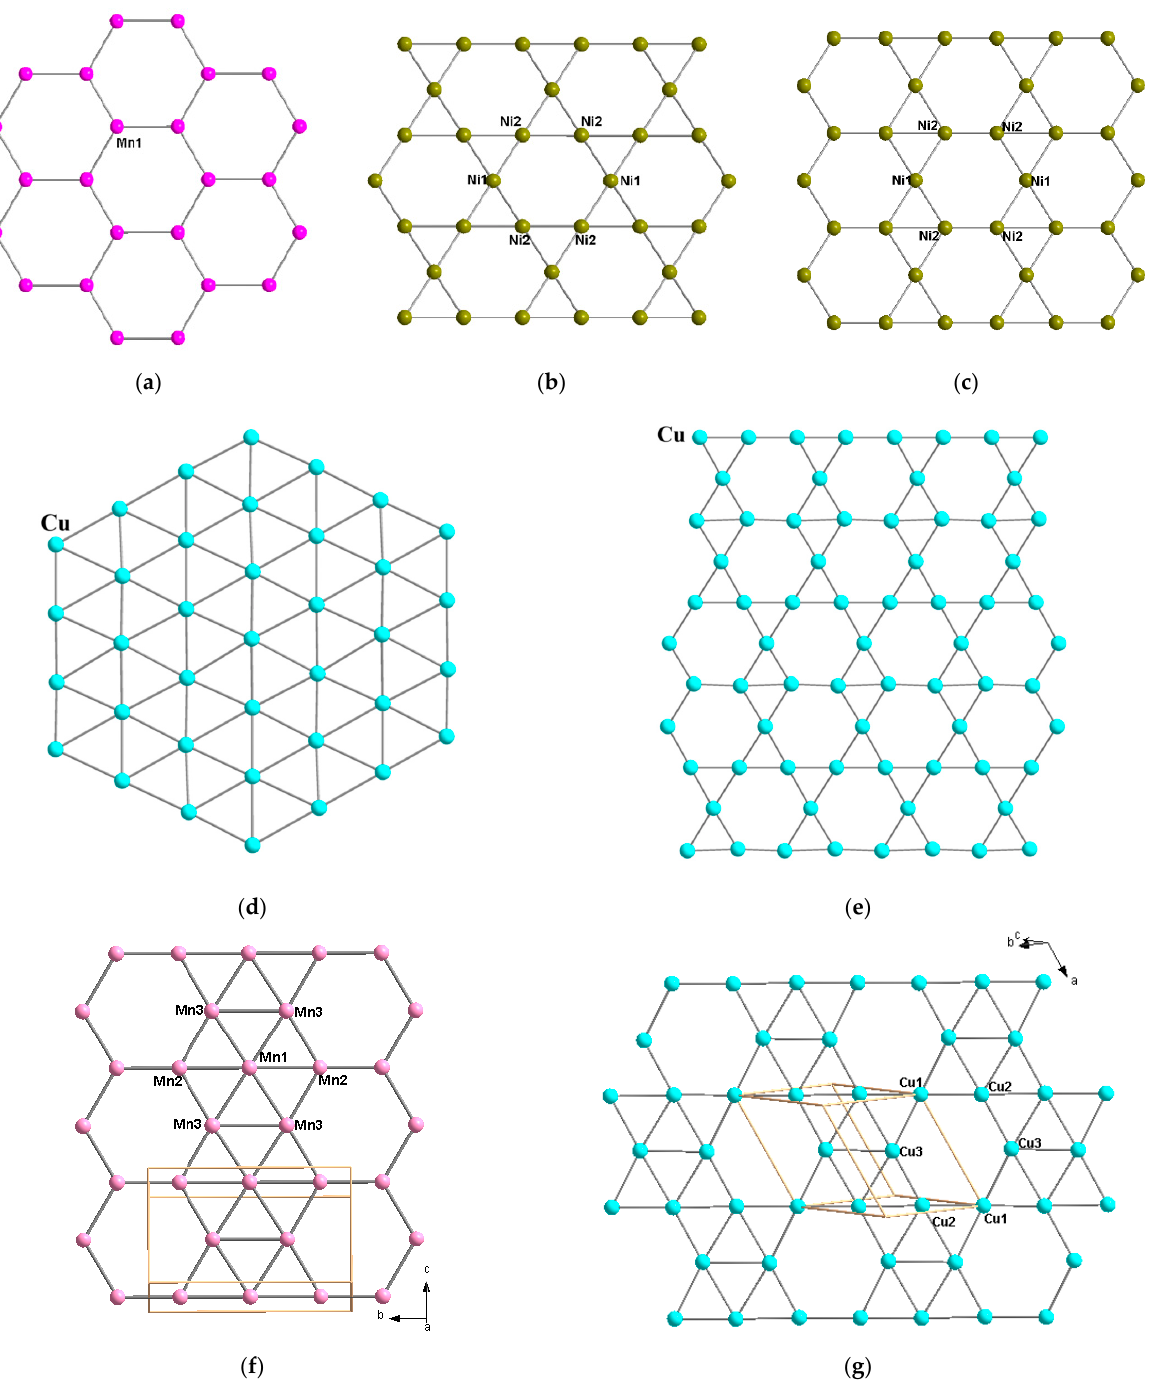
Figure 3. The topology of magnetic subsystems (cationic substructures): the honeycomb-type (or graphite-type) lattice characteristic of the gibbsite layer (the cationic substructure of the core modules in vanadate carbonates, BaNi 2 [VO 4 ] 2 and other double vanadates, arsenates and phosphates) ( a ); The kagomé lattice (bayldonite, Pb(Cu,Zn) 3 (OH) 2 [AsO 4 ] 2 and vésignéite, BaCu 3 (OH) 2 [VO 4 ] 2 ) ( b ); The stripes of the triangular net separated by honeycombs (Na 2 Ni 3 (OH) 2 [PO 4 ] 2 and K 2 Mn 3 (OH) 2 [VO 4 ] 2 ) ( c ); The triangular lattice inherent for the brucite-type layers (the cationic substructure of the B mod- ule in Cu 13 (OH) 10 F 4 [VO 4 ] 4 ) ( d ); The stepped stripes of the triangular net separated by honeycombs (Cu 13 (OH) 10 F 4 [VO 4 ] 4 ) ( e ); The dual-width stripes of the triangular net separated by honeycombs (reppiaite, Mn 5 (OH) 4 [VO 4 ] 2 ) ( f ); The du- al-width stepped stripes of the triangular net separated by honeycombs (cornubite, Cu 5 (OH) 4 [AsO 4 ] 2 ) ( g ).